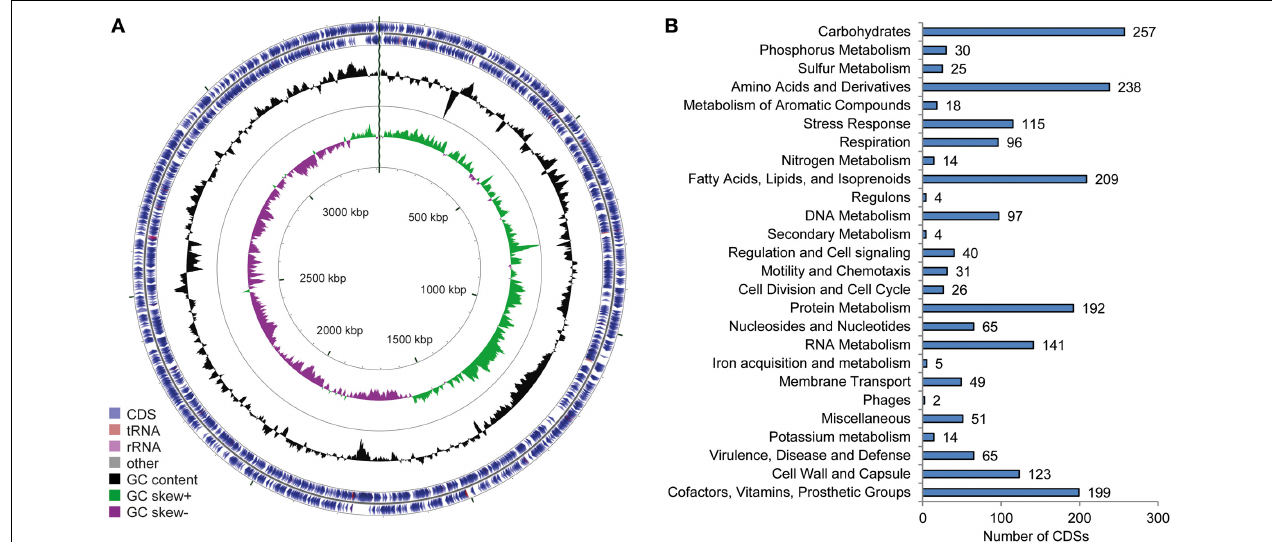
FIGURE 2 | Overview of the “ Ca. Phaeomarinobacter ectocarpi” Ec32 genome. (A) illustration of the genome structure generated using CGView (Stothard and Wishart, 2005); (B) summary of subsystems identified using RAST (Aziz et al.,